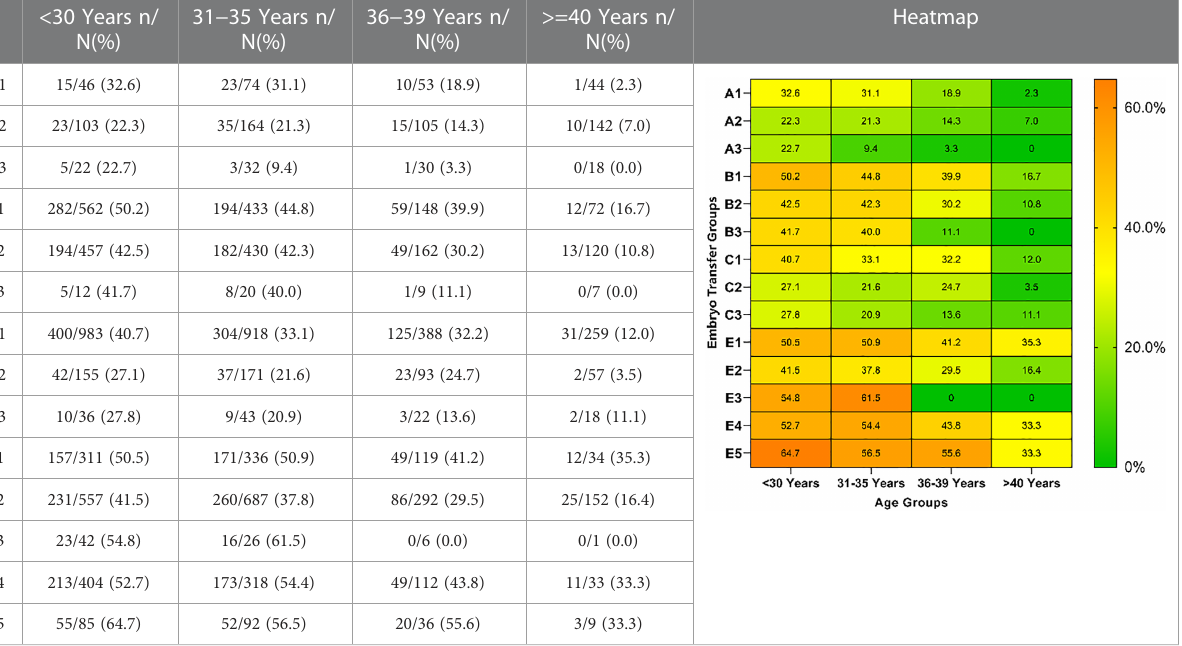
TABLE 5 Live birth rate of different embryo transfer groups based on women ’ s